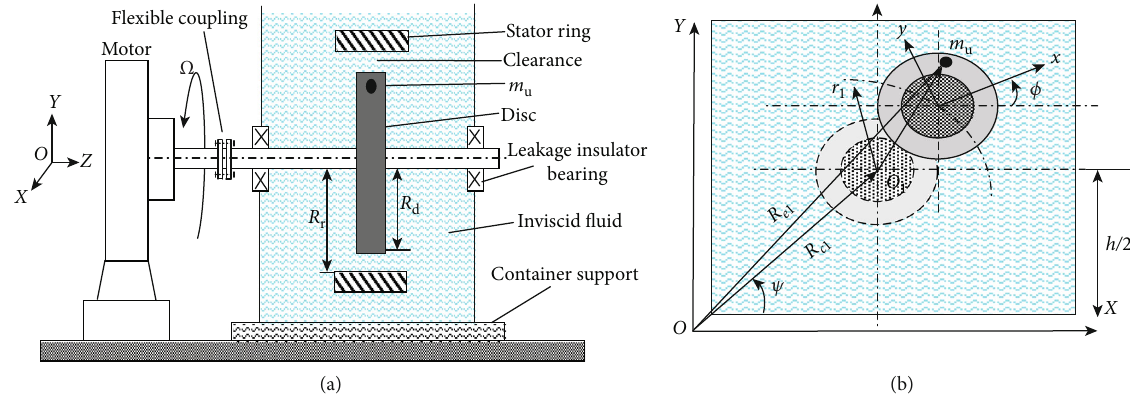
Figure 1: (a) Schematic of the fl uid-rotor-stator system. (b) View of a disc in fi xed